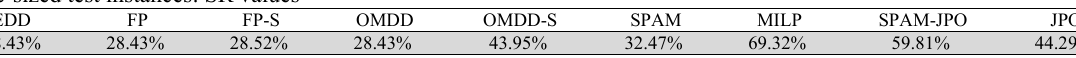
Large-sized test instances: SR